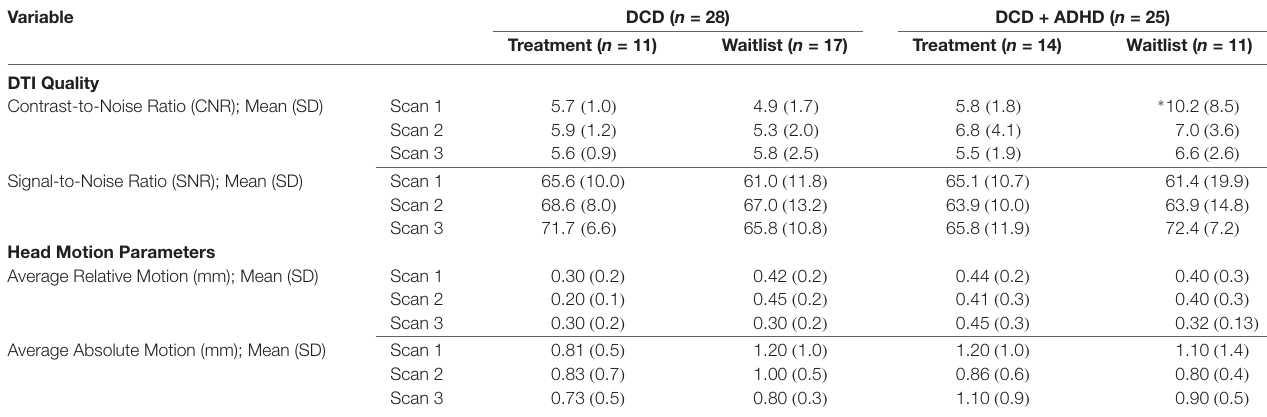
TABLE 2 | DTI quality and head motion